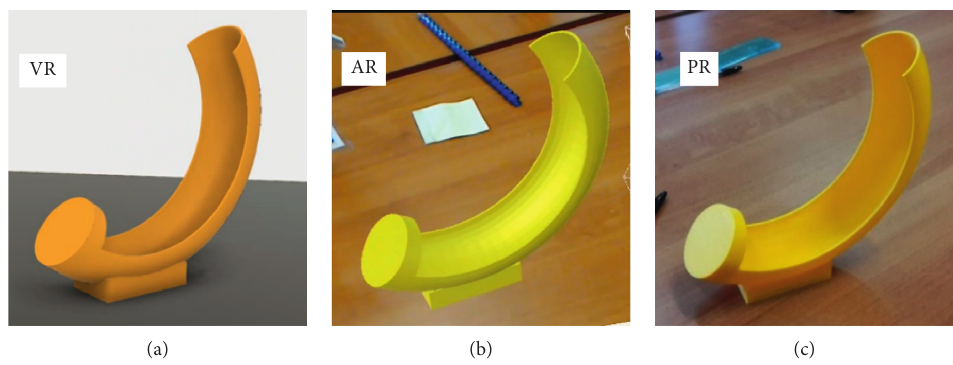
Figure 2: VR, AR, and PR representations of Sh1 and environment as used in the Table 4: Designers’ characteristics in the DPE early validation. Characteristic